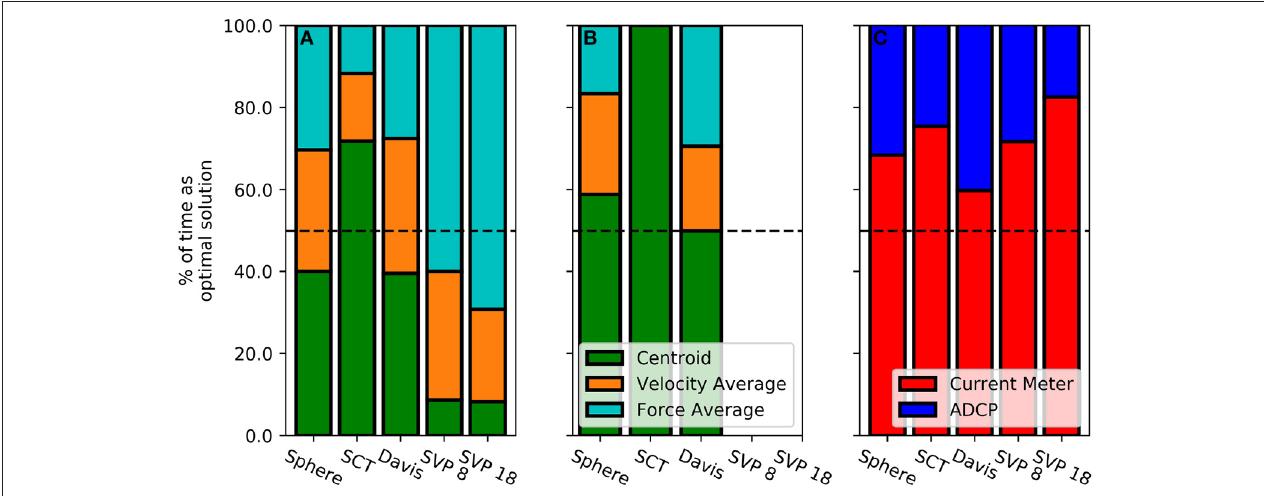
FIGURE 8 | Percentage of time current shear (A) and Stokes drift (B) profiles applied via the centroid and area-weighted average of velocity or force produce the optimal solution for a the trajectories of each of the five drifters. No results are shown for Stokes drift on the SVP drifters, as the analysis indicates that Stokes drift does not contribute to the optimal trajectory prediction at any time. (C) Shows the percentage of time the currents measured by the current meter (red) and the ADCP (blue) contribute to the optimal